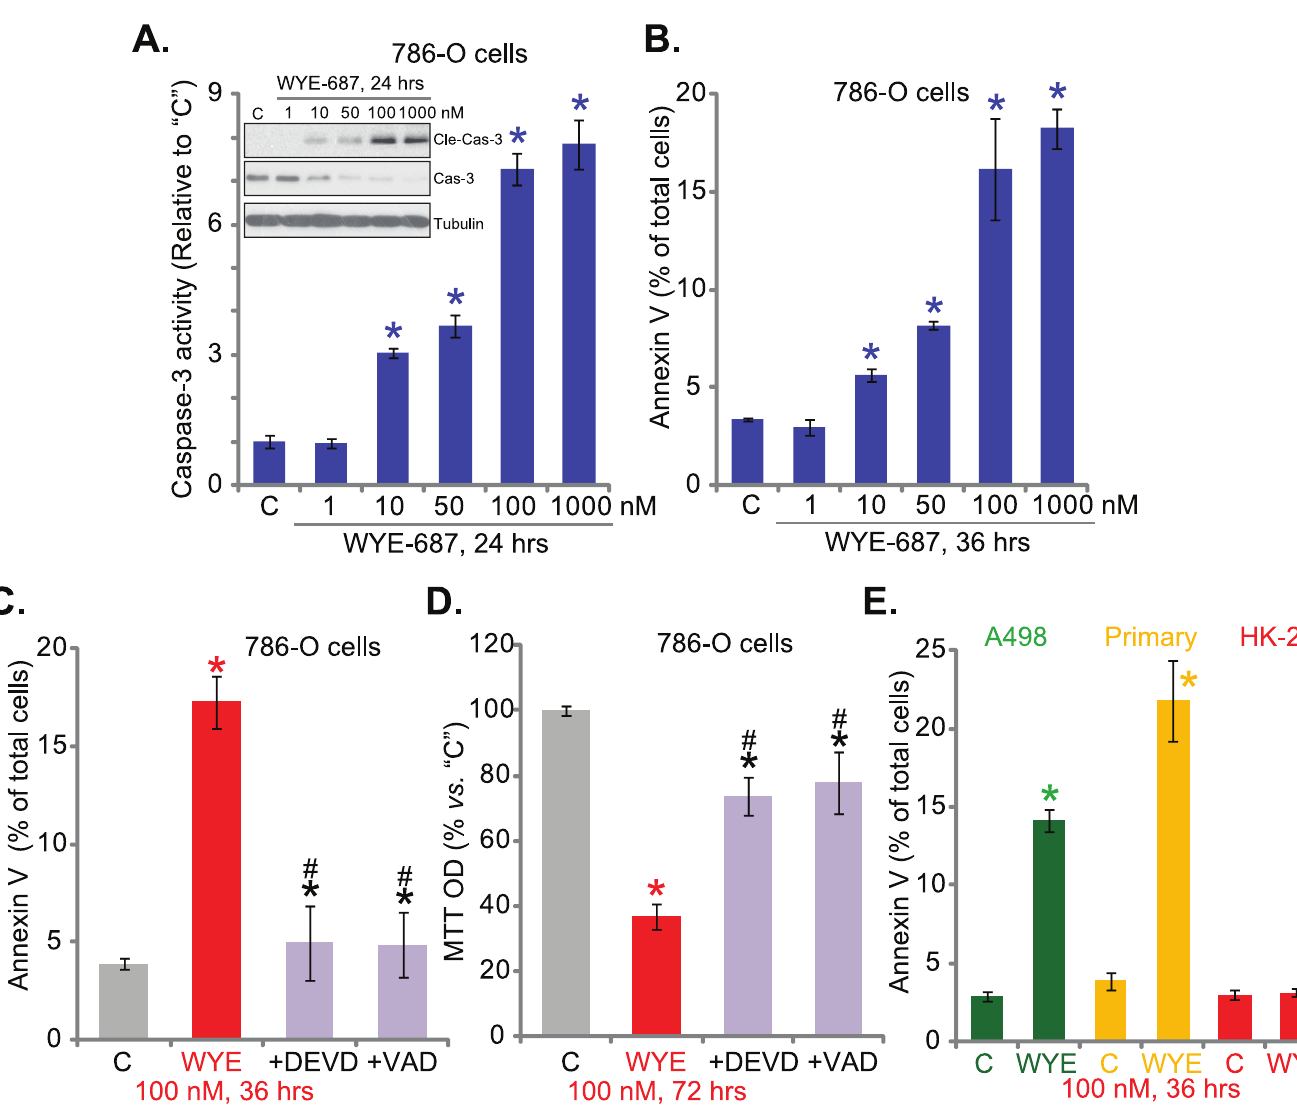
Fig 2. WYE-687 induces apoptosis in cultured human RCC cells. RCC cell lines (786-O and A498), primary human RCC cells (“Primary”), or HK-2 normaltubular epithelialcells were treated with describedWYE-687 (“WYE”) for appliedtime, cell apoptosiswas tested by listed assays (A, B, E, n = 3). For C and D, 786-O cells were pre-treatedfor 1 hour with Ac-DEVD-cho (“+DEVD”, 50 μ M) or Ac-VAD-cho (“+ VAD”, 50 μ M) before appliedWYE-687 treatment, cell apoptosis(AnnexinV assay, C, n = 3) and survival (MTT assay, D, n = 5) were tested. * p < 0.05 vs. untreatedcontrol group (“C”). # p < 0.05 vs. WYE- 687treatment only (C and